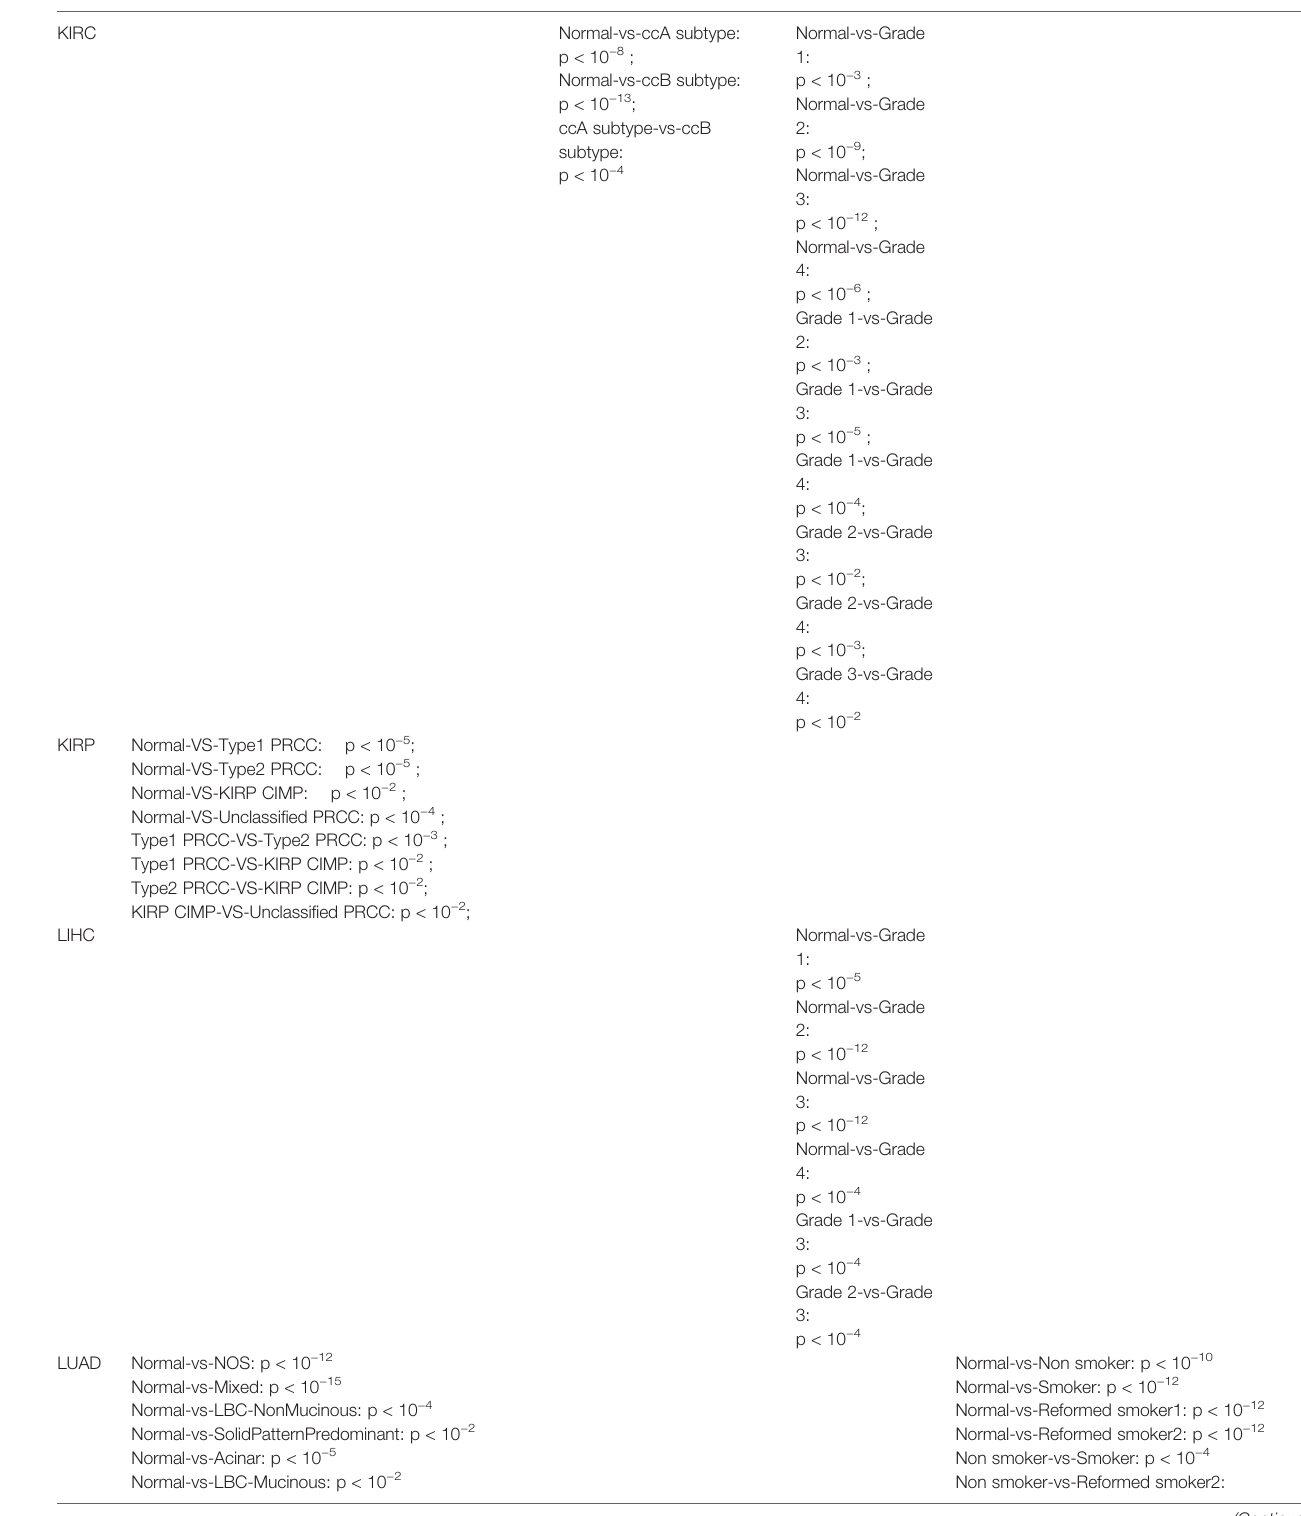
TABLE 1 | Statistically signi fi cant ASPM overexpression based on histological, molecular subtypes, and different patient statuses (only fi ndings with p-value < 0.05 are given).